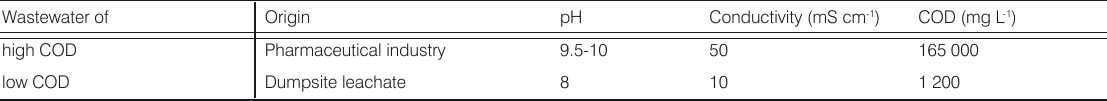
Table 2. Parameters of the wastewaters